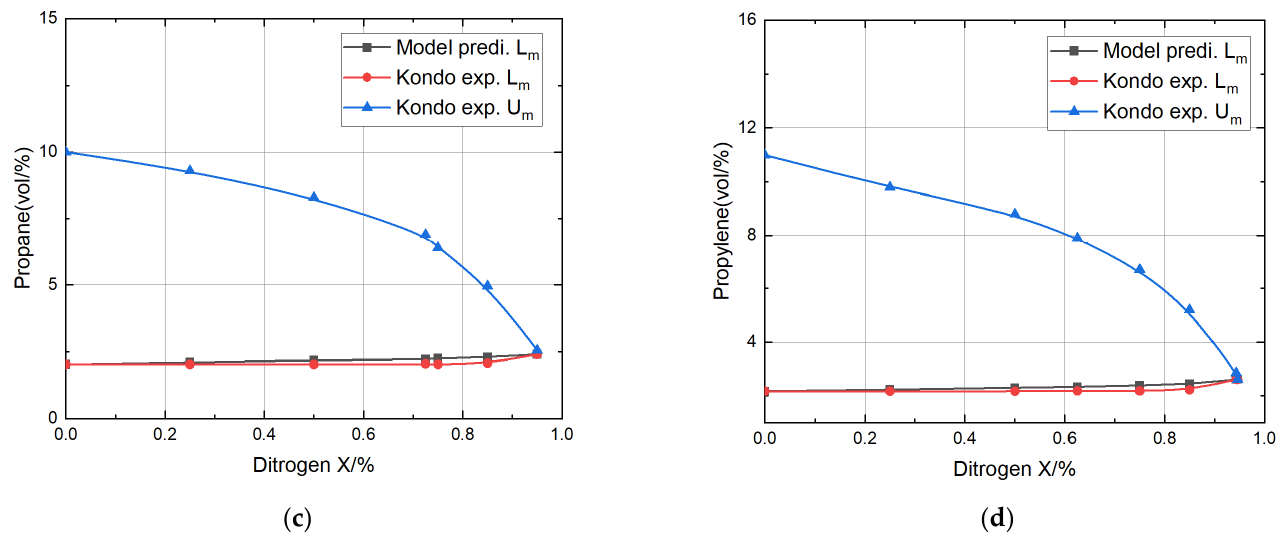
Figure 1. Standard flammability diagrams of methane, ethylene, propane and propylene mixed with nitrogen. Calculation of the explosion limit of ( a ) “methane + nitrogen”; ( b ) “ethylene + nitrogen”; ( c ) “propane + nitrogen”; ( d ) “propylene + nitrogen”.